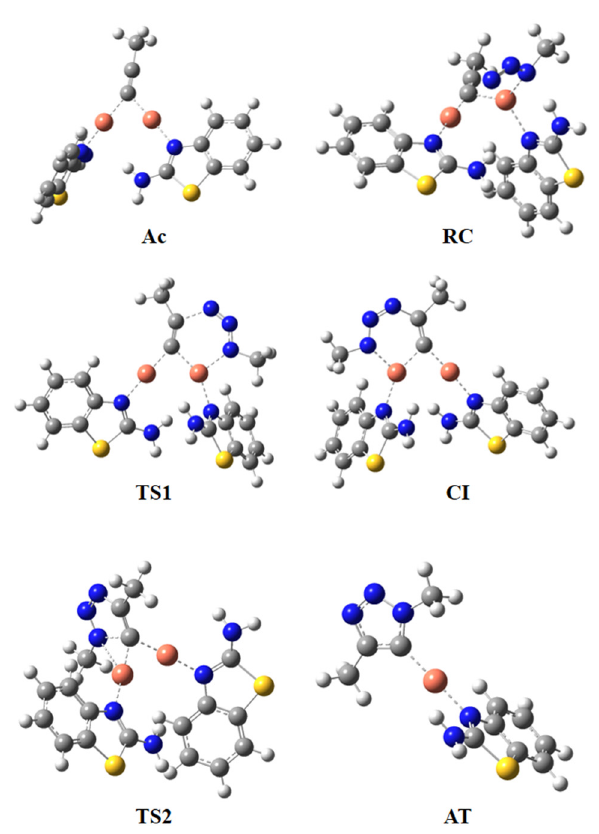
Figure 3. Optimized geometries of the stationary points involved in the dinuclear CuAAC reaction of Ac with 5 .